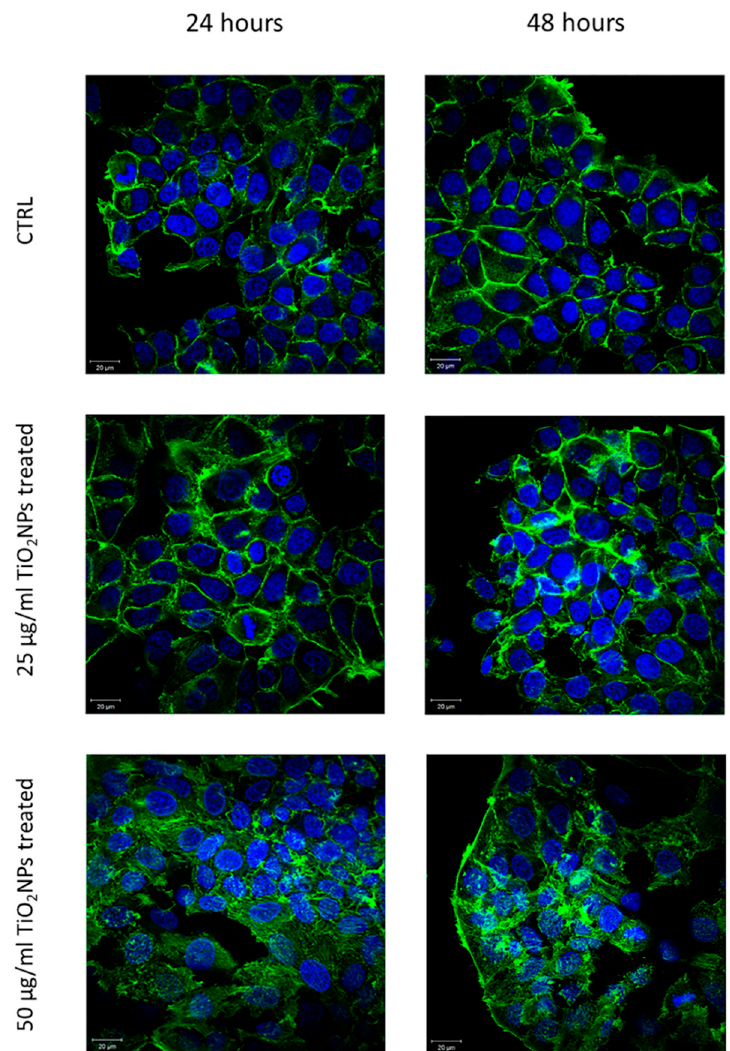
Figure 5. Representative confocal acquisitions on MCF-7 cells control and treated with 25 and 50 µg/mL TiO 2 NPs, at two different exposure times: 24 and 48 h. Cells fixed were labelled with DAPI (D9542, Sigma Aldrich) and phalloidin-FITC (P5282, Sigma Aldrich). The images were acquired by a Zeiss LSM700 (Zeiss, Germany) confocal microscope implemented on Axio Observer Z1 (Zeiss, Germany) inverted microscope using an oil immersion objective (×100, 1.46 NA). All data were processed by ZEN software (Zeiss, Germany).